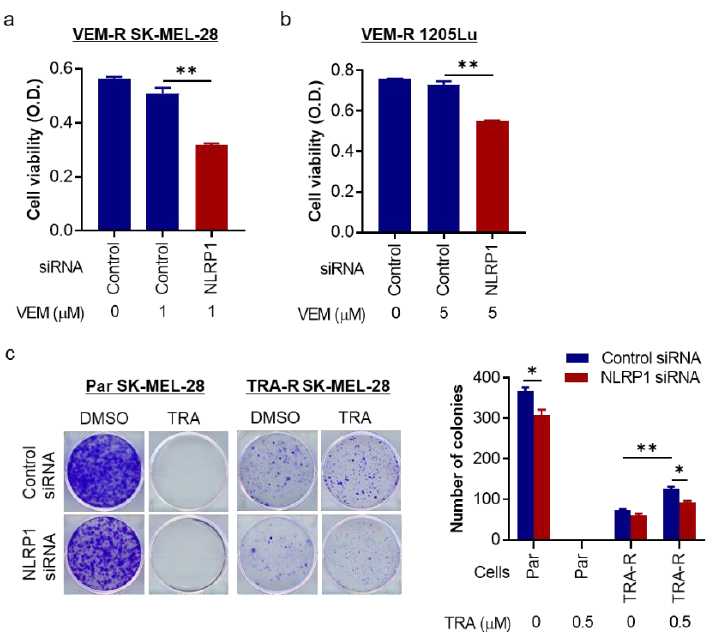
Figure 5. Silencing NLRP1 slows down resistant cell growth and colony formation. ( a ) Cell viability assay of VEM-resistant (VEM-R) SK-MEL-28 cells transfected with 50 nM control or NLRP1 siRNA overnight and treated with 1 µM VEM for 48 h. ( b ) Similarly, cell viability assay of NLRP1 siRNA transfected VEM-R 1205Lu cells treated with 5 µM VEM for 48 h. ( c ) NLRP1 siRNA transfected parental or TRA-resistant (TRA-R) SK-MEL-28 cells treated with DMSO or 0.5 µM TRA for 7 days, assessed for colony formation by crystal violet staining (left) and quantitated (right). Representative images are shown and data expressed as the mean ± SEM, n = 4. * p < 0.05 and ** p < 0.01.